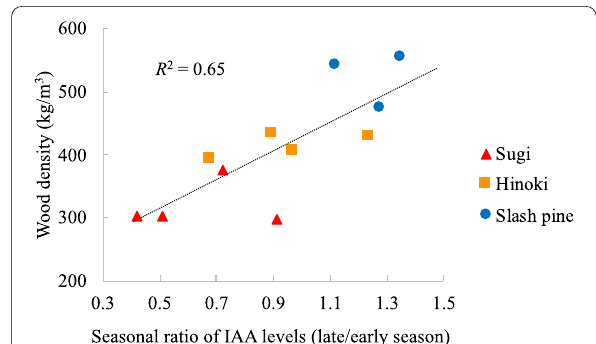
Fig. 7 Relationships between seasonal ratio of IAA levels and wood density in three conifers. The seasonal ratio of the IAA levels is the ratio of the average value of the IAA levels during late season (July, September, and November) to that during early season (May and the following